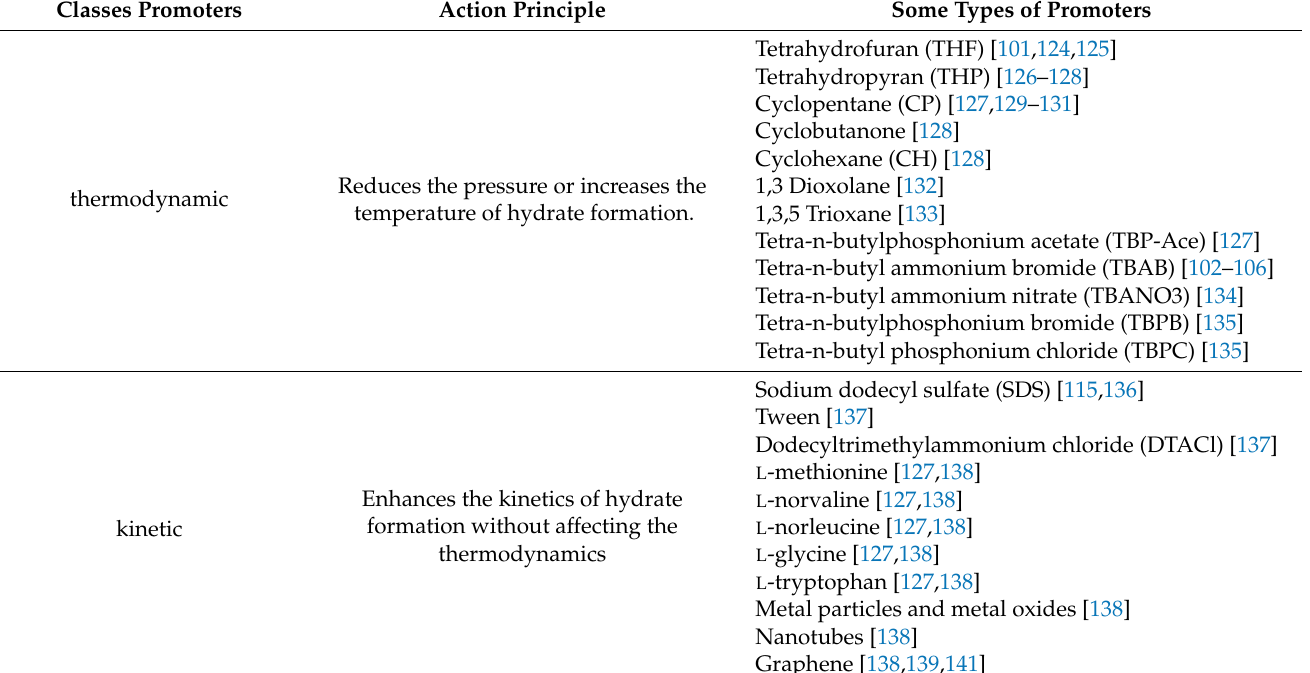
Table 1. Classification of promoters for CO 2 hydrate